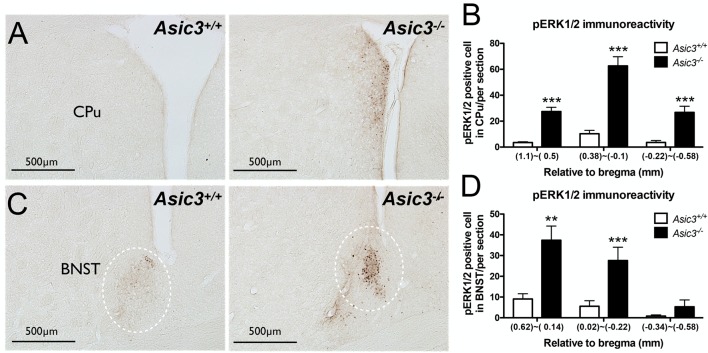
Phosphorylated extracellular signal-regulated kinase 1/2 (pERK) activity in dorsomedial striatum and bed nucleus of the stria terminalis (BNST) of Asic3−/− and Asic3+/+ mice. (A) Representative images of pERK activation in striatal caudate putamen (CPu) in Asic3+/+ and Asic3−/− mice. The pERK activity measured by pERK staining of brain sections revealed enhanced activation in striatum in Asic3−/− mice. (B) Quantification of pERK+ cells in CPu. The pERK+ cells were significantly increased in CPu in Asic3−/− mice as compared with Asic3+/+. N = 3–5 mice per group. (1.1~0.5mm, Asic3+/+
n = 36 slices, Asic3−/−
n = 36 slices, t = 7.191 df = 70; 0.38~-0.1mm, Asic3+/+
N = 24 slices, Asic3−/−
N = 18 slices, t = 7.661 df = 40; −0.22~-0.58mm, Asic3+/+
n = 16 slices, Asic3−/−
n = 14 slices, t = 5.012 df = 28, ***p < 0.001). (C) Representative images of pERK activation in BNST in Asic3+/+ and Asic3−/− mice. (D) Quantification of pERK+ cells in BNST. The pERK+ cells were significantly increased in BNST in Asic3−/− mice as compared with Asic3+/+ mice. N = 3–5 mice per group (0.62~0.13mm, Asic3+/+
n = 22 slices, Asic3−/−
n = 22 slices, t = 3.900 df = 42; 0.02~-0.22mm, Asic3+/+
n = 14 slices, Asic3−/−
n = 10 slices, t = 3.538 df = 22; -0.34~-0.58mm, Asic3+/+
n = 12 slices, Asic3−/−
n = 10 slices, **p < 0.01, ***p < 0.001). Data represent mean ± SEM. Data analyzed by two-tailed unpaired t-test.